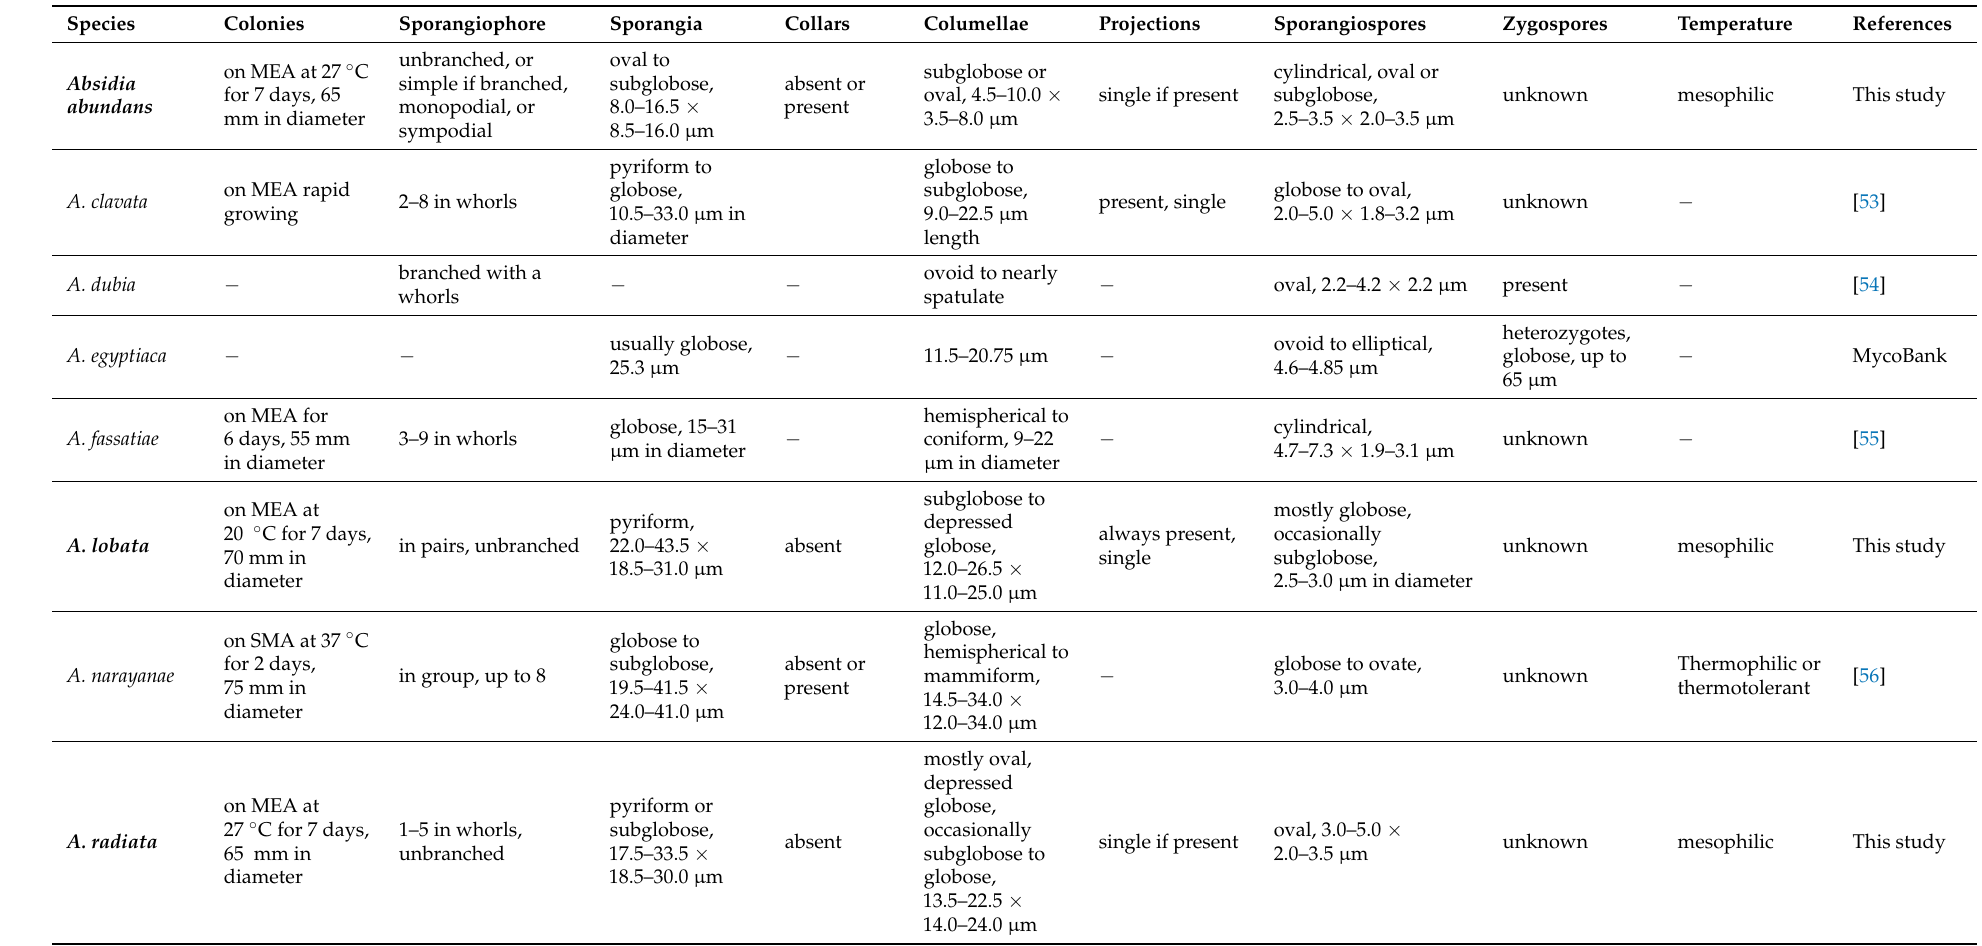
Table 4. Morphological features of the five new Absidia species and other six related species without DNA